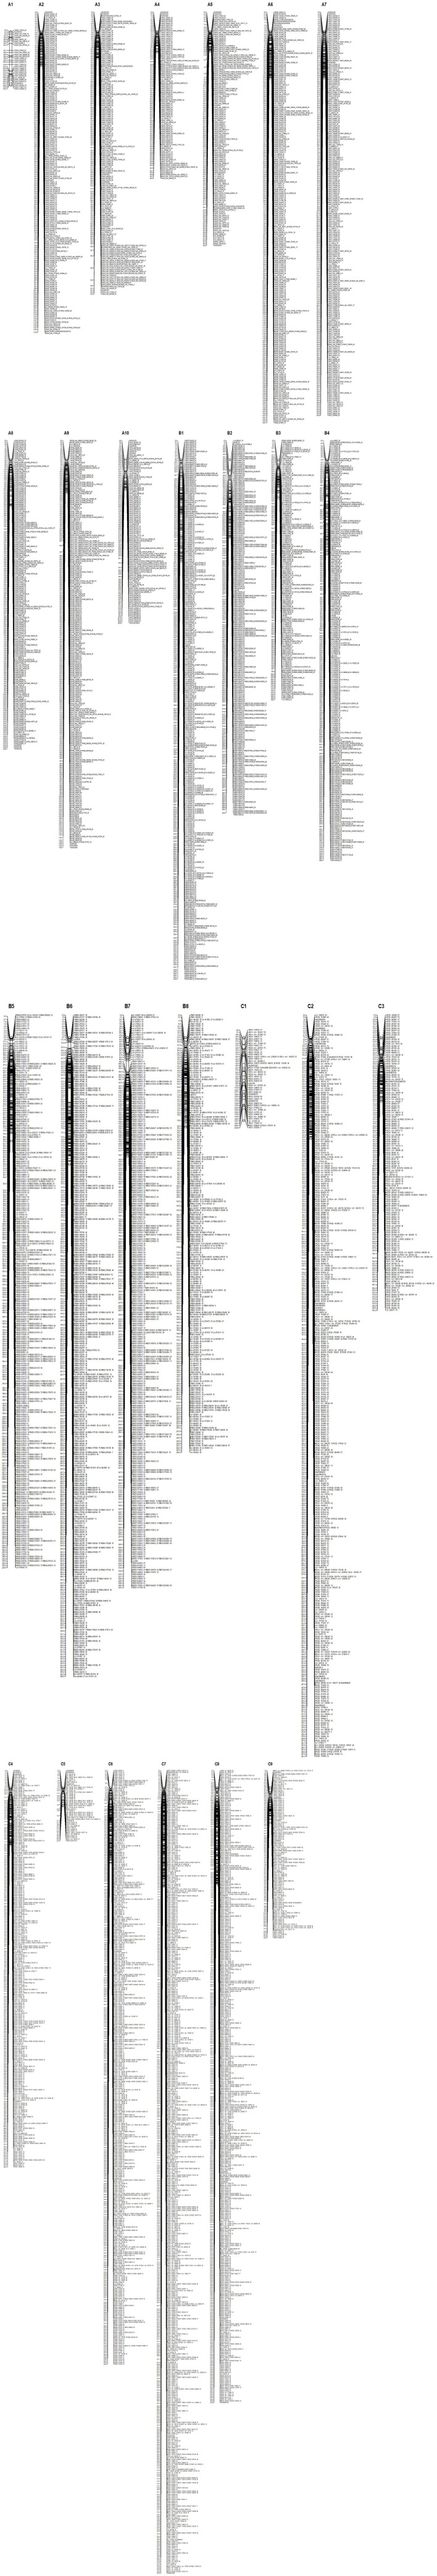
The allohexaploid Brassica genetic linkage map formed from a doubled haploid mapping population derived from allohexaploid Brassica hybrid H16-1. The map is composed of 27 chromosomes including 10 A genome, 8 B genome and 9 C genome chromosomes with 7,499 SNP markers and spans 5,714.82 cM. The map distances are shown on the left of the chromosome while the names of the SNP markers are indicated on the right.